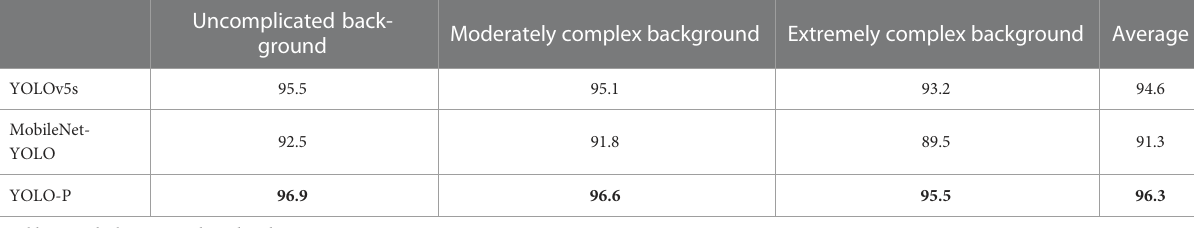
TABLE 6 F1 score (%) in different background complexities experiments during daytime. Uncomplicated back- Moderately complex background Extremely complex background Average ground